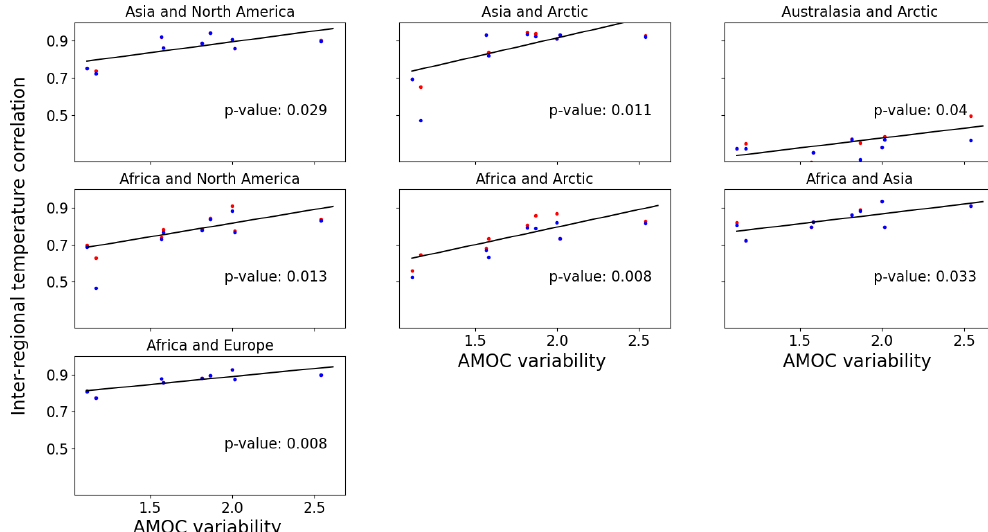
Figure 4. Simulated relationship of lagged (red dots) inter-regional temperature correlations as a function of AMOC variability. Results and the linear trend lines are only shown when the relationship is significant ( p < 0 . 05; p values given on the bottom right). For reference, we also show the non-lagged correlation results (blue dots). Calculating the lagged correlations is done per continental time series.